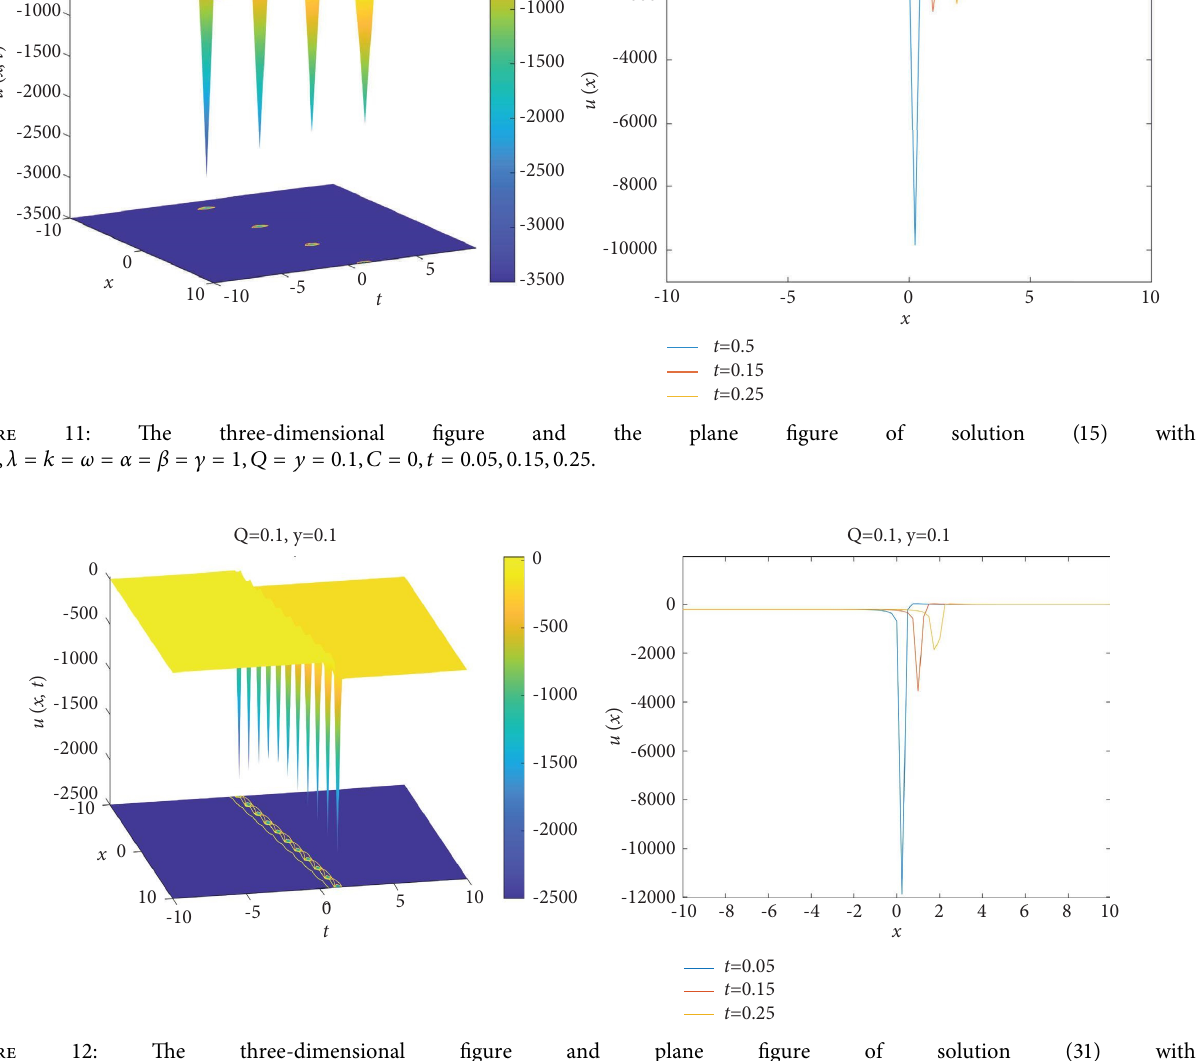
12: Te three-dimensional fgure and plane fgure of solution